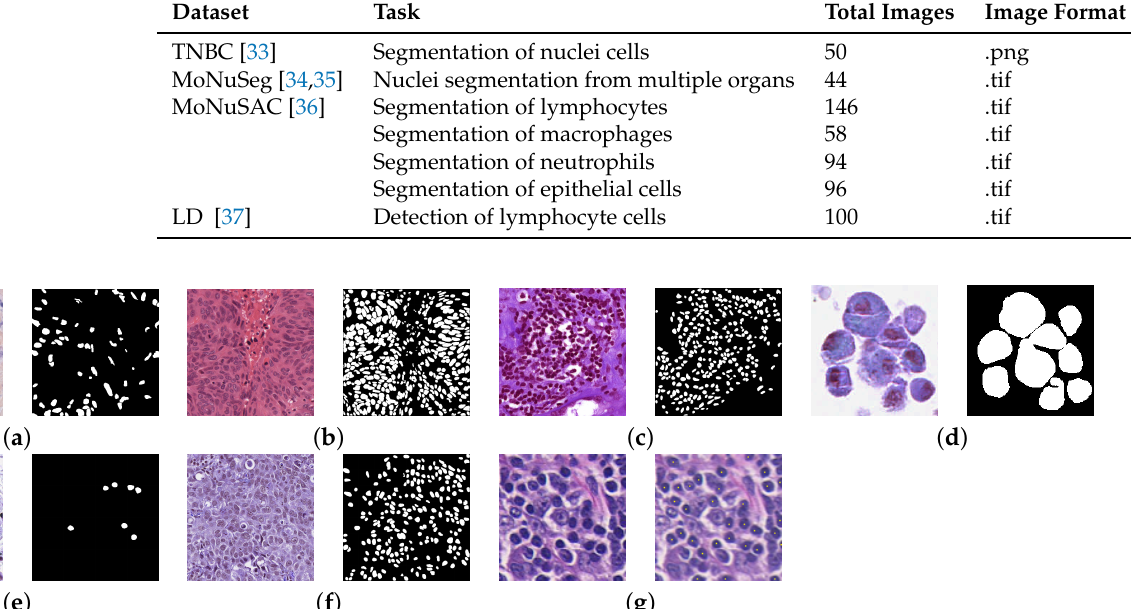
Figure 1. Sample images and their corresponding masks from the datasets: ( a ) TNBC. ( b )